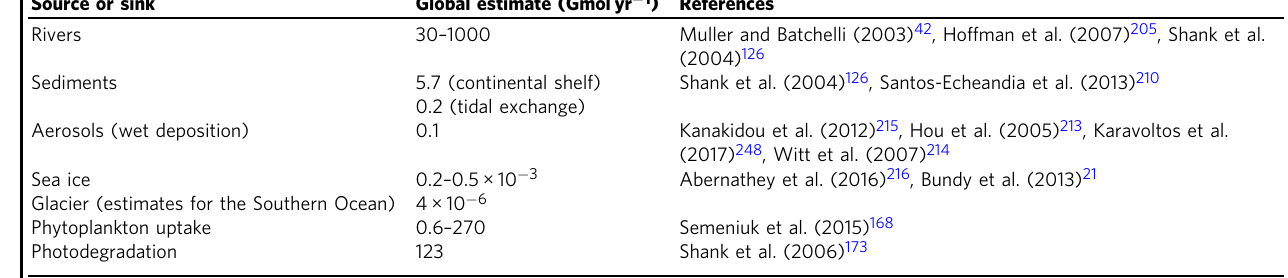
Table 4 Global estimated fl uxes of copper-binding